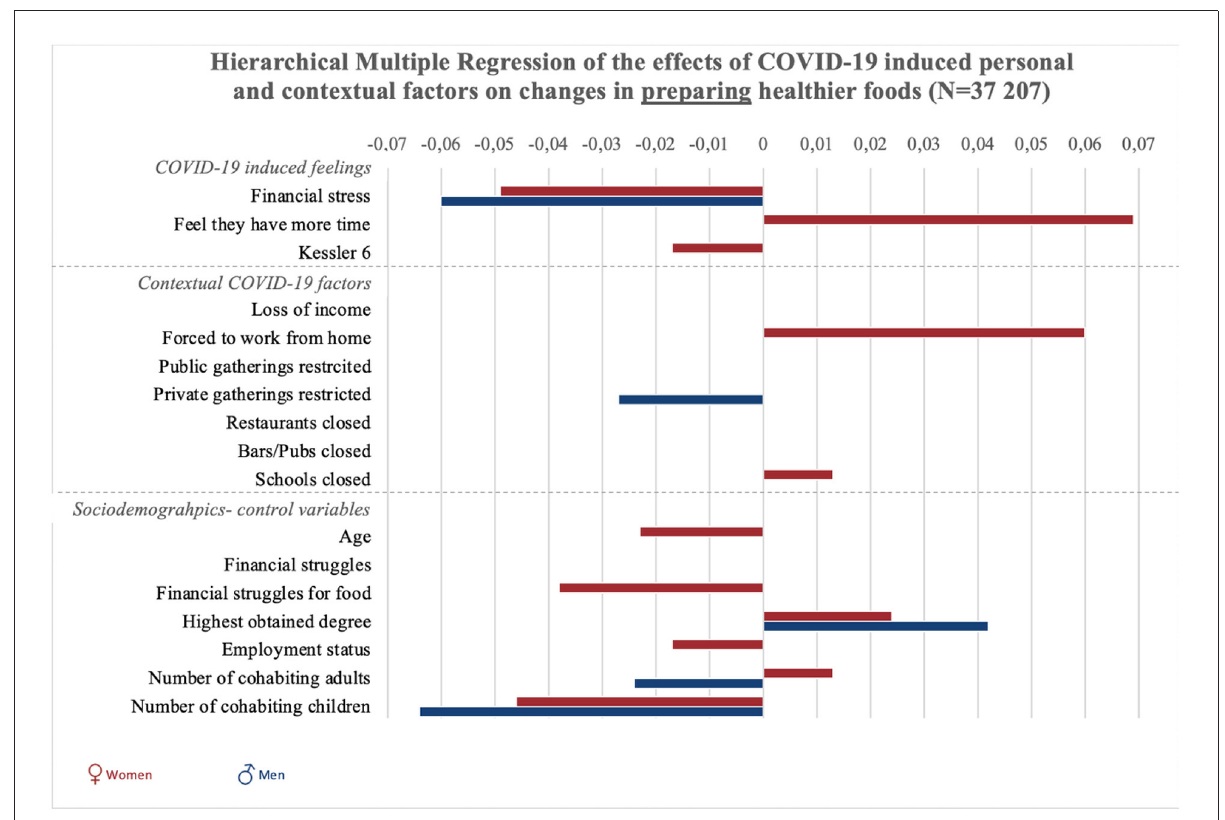
FIGURE3 Graphic summary of the significant relations between personal, contextual and sociodemographic variables and changes in preparing healthier foods during COVID-19. We report beta-values only for significant relations in models 2 for preparing healthier foods. Bars to the right indicate improvement in food preparation, bars to the left indicate decreases in preparing healthy